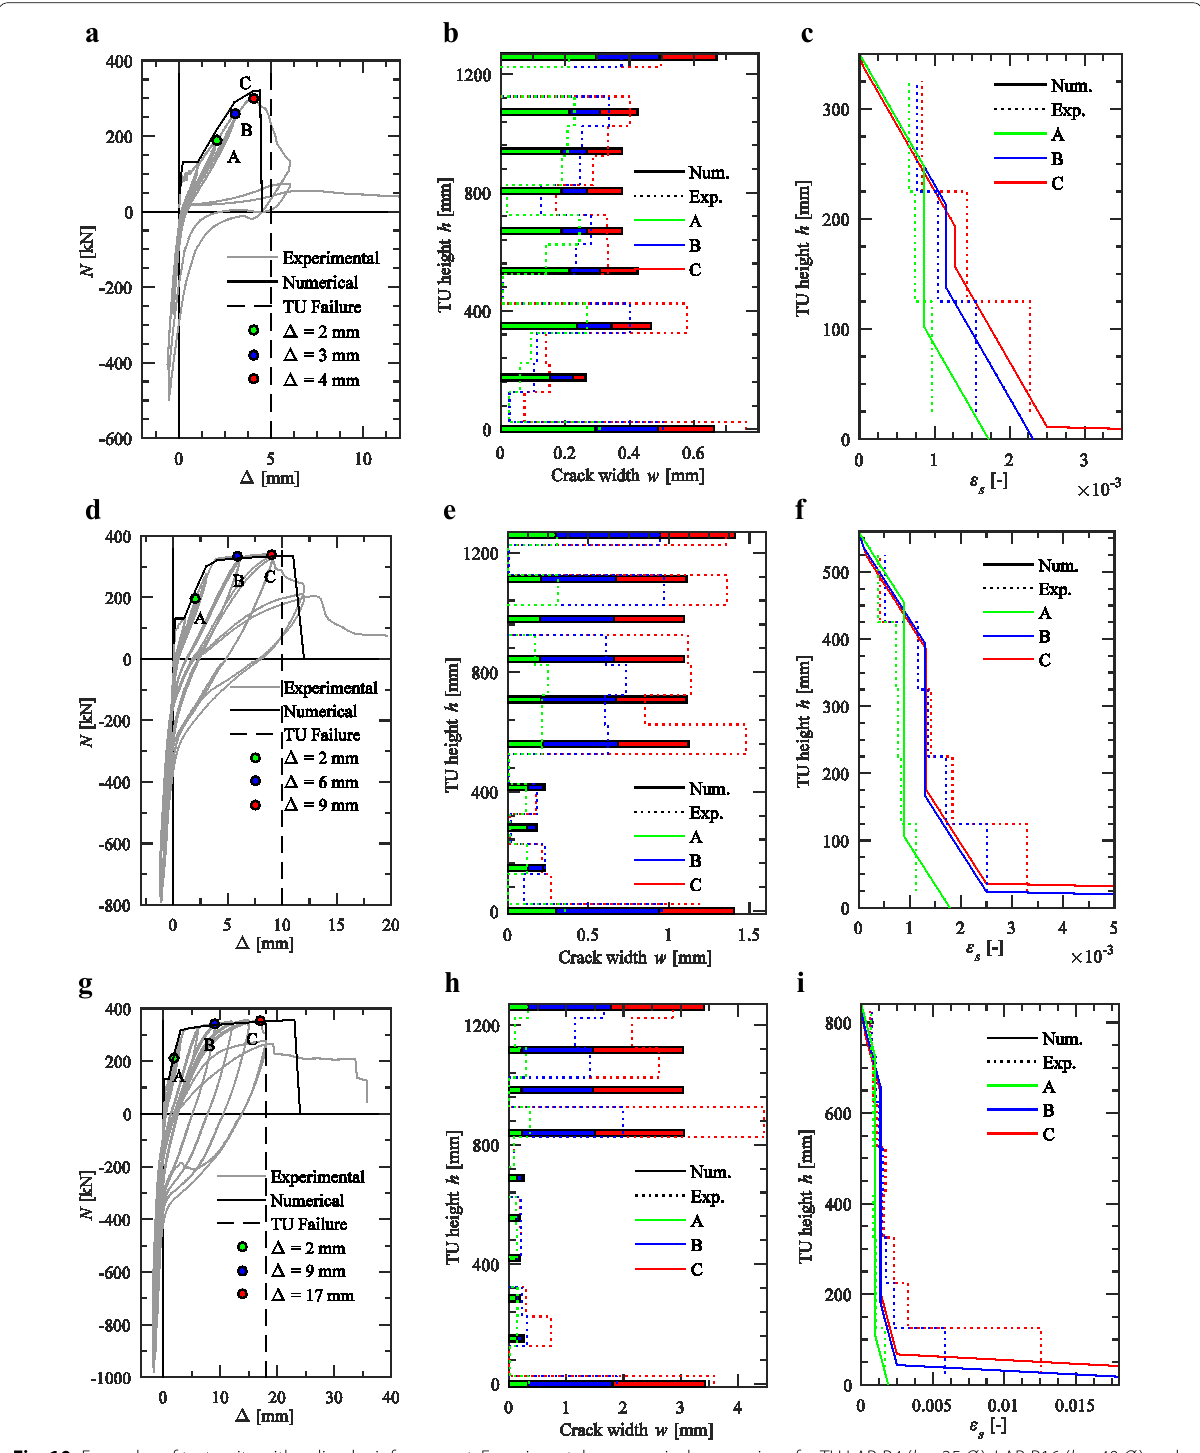
Fig. 10 Examples of test units with spliced reinforcement: Experimental vs numerical comparison for TU LAP-P4 ( l s LAP-P5 ( l s 60 Ø l ): a , d , g Force–displacement response. b , e , h Crack width. c , f , i Steel strains within the lap-splice region for the bottom anchored =